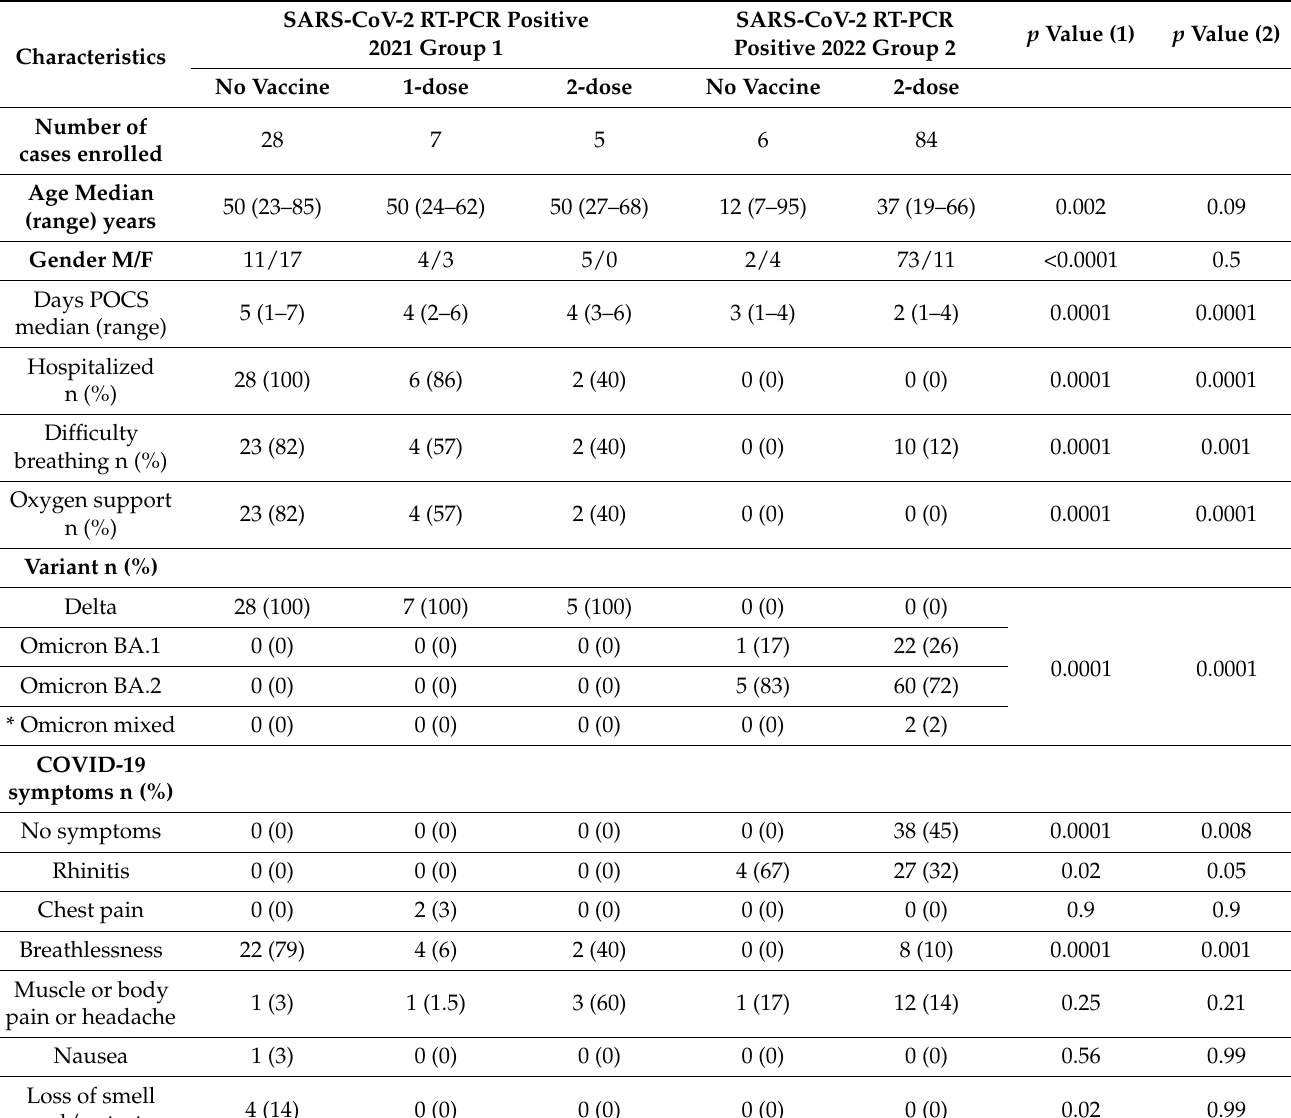
Table 1. Patient Characteristics. The patient characteristics were compared in two groups of SARS- CoV RT-PCR positive COVID-19 in the Dhaka region: Group 1 in the period between 13 September and 23 October 2021, and Group 2 in the period between 9 January and 10 February 2022. The p -value p (1) represents the difference between no vaccine Group 1 versus no vaccine group 2. The p -value p (2) represents the difference between Group 1 receiving either one or two vaccine doses versus Group 2 receiving two vaccine doses. The differences between the median age, the proportion of gender, and the median days post onset of COVID-19 symptoms (POCS) were determined by the Mann–Whitney sum rank test. The differences between the number of cases n and (percent) between the two groups were determined by Chi-square analysis. * Omicron mixed refers to the detection of both the BA.1and BA.2 sub-variants in the same patient swab